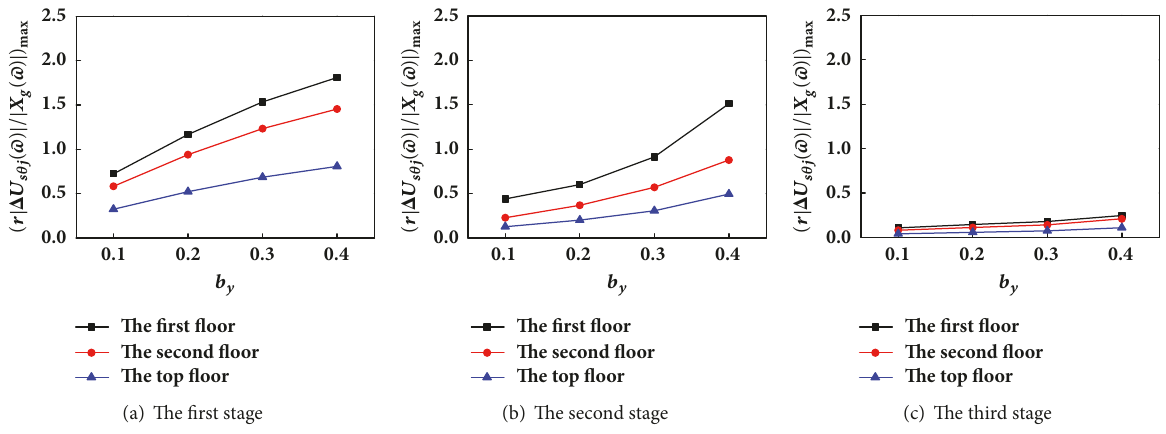
Figure 14: Interstory torsion displacement under different 𝑏 𝑦